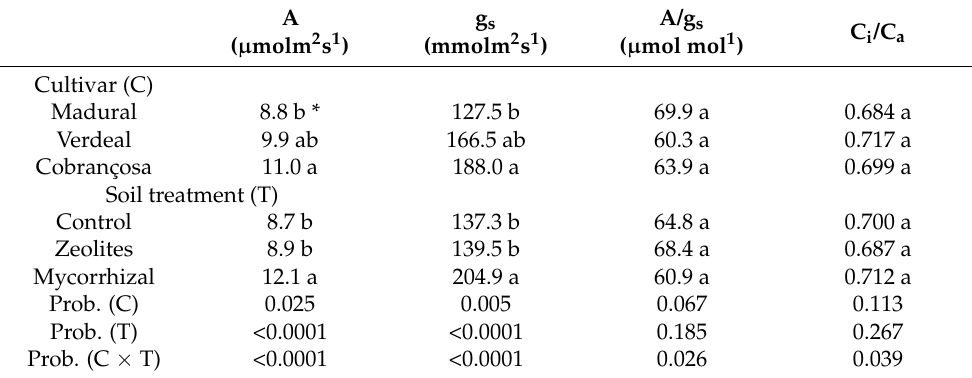
Table 3. Net photosynthetic rate (A), stomatal conductance to water vapor (g s ), intrinsic water use efficiency (A/g s ), and ratio of intercellular to atmospheric CO 2 concentration (C i /C a ) as a function of cultivar and soil amendment.